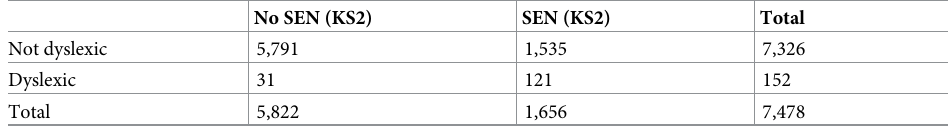
Table 1. Those labelled as dyslexic and on the SEN register at age 11,